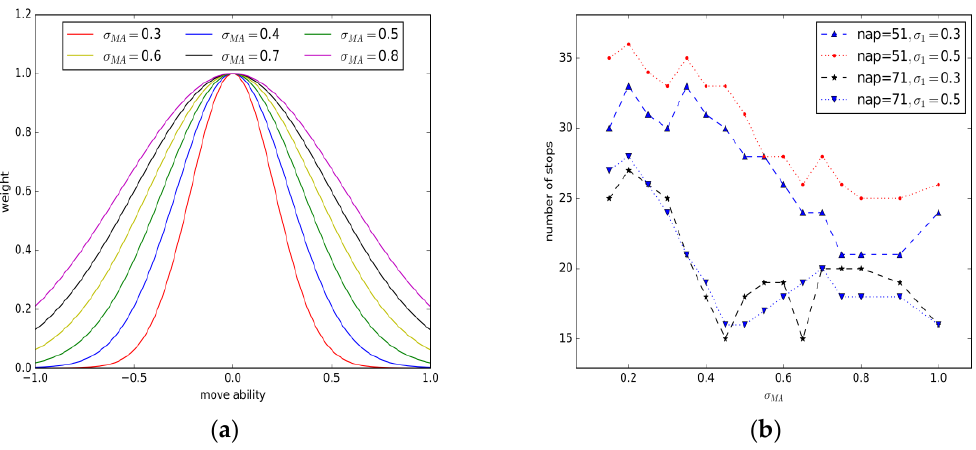
Figure 7. The estimation simulations of parameter 𝜎 𝑀𝐴 . ( a )The variation of move ability weight with parameter 𝜎 𝑀𝐴 ; ( b ) the number of stops found for different 𝜎 𝑀𝐴 .